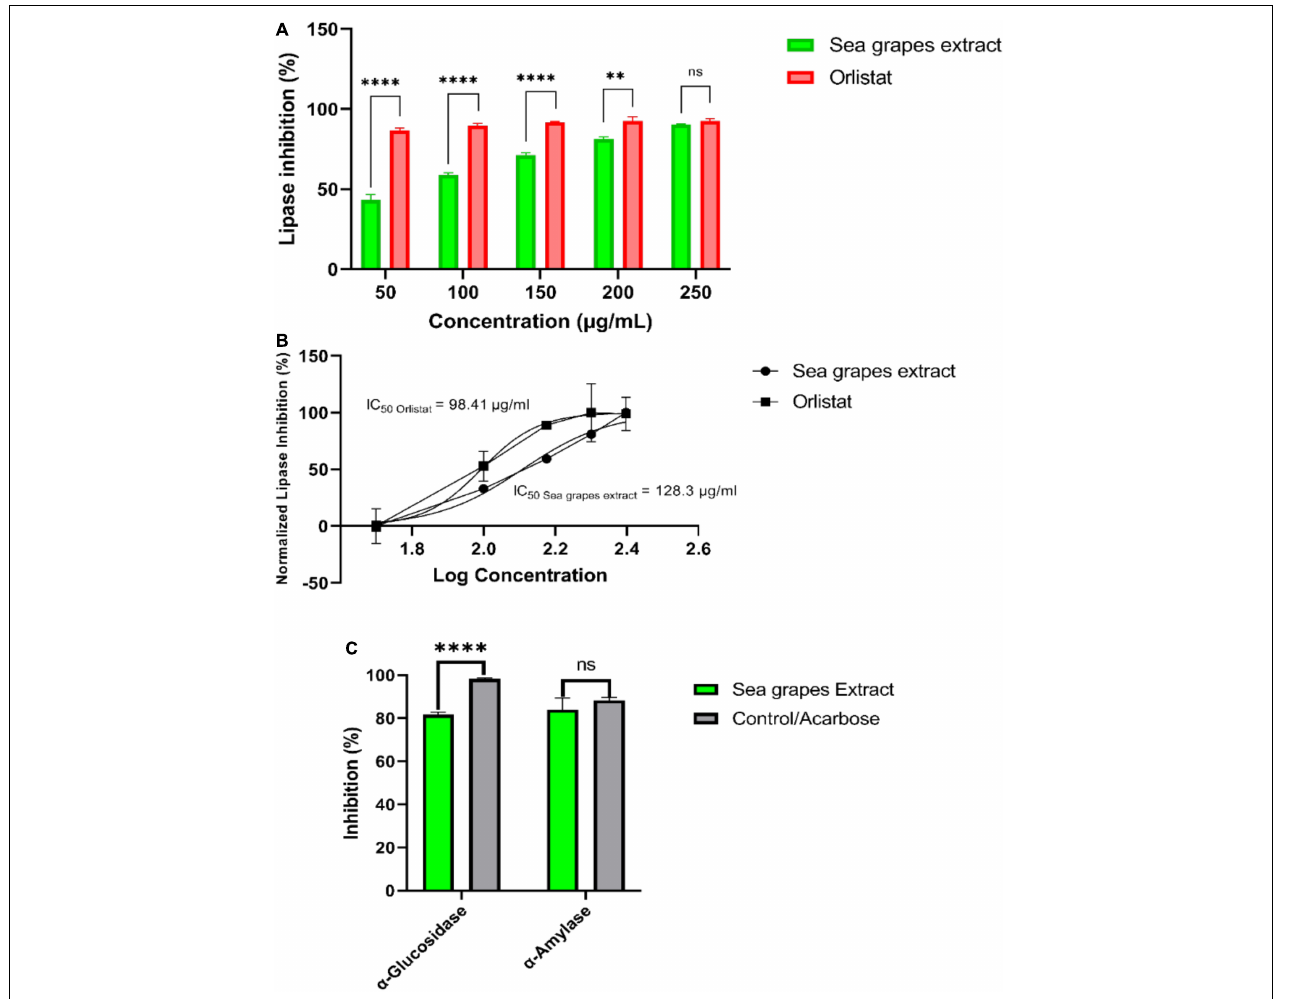
FIGURE 3 | In vitro studies of sea grape inhibitory activity of lipase, α -glucosidase , and α -amylase . ** p = 0.026; **** p < 0.0001.